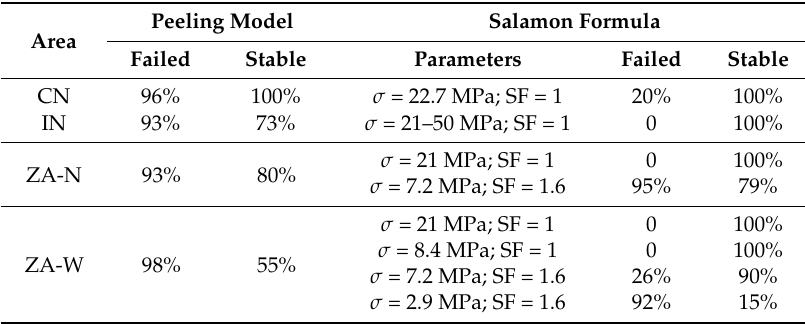
Table 4. The accuracy of evaluation with different